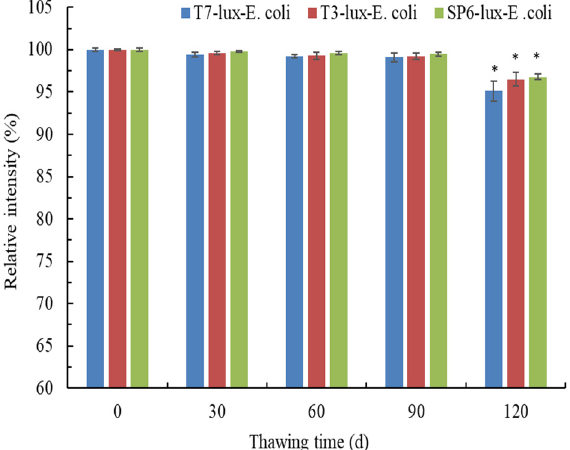
Figure 5. Effects of thawing time on luminescence intensities of three recombinant E. coli biosensors induced with 0.5 mg/L Cr(VI) for 1.5 h (T7-lux- E. coli ), 1 h (T3-lux- E. coli ), and 0.5 h (SP6-lux- E. coli ). Data are expressed as the means ± standard deviations of three independent experiments (* p < 0.05 vs. blank control).